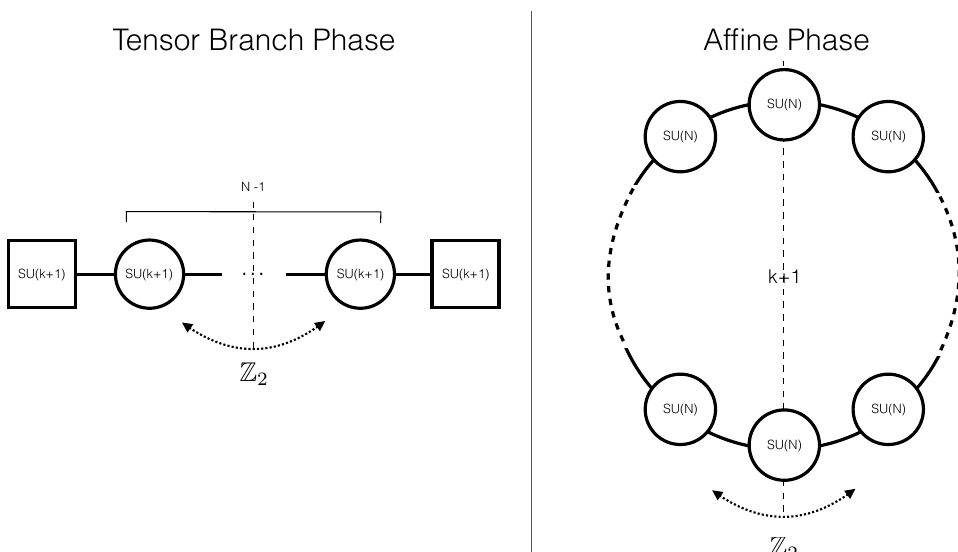
Figure 1 . The two quiver phases of A-type class S theories compacti(cid:12)ed on a T 2 . In addition, (cid:0) the e(cid:11)ect of quotienting by the global symmetries associated to the outer automorphisms is shown. On the left the reduction on the tensor branch yields ( N (cid:0) 1) SU( k + 1) gauge nodes and two SU( k + 1) (cid:13)avor symmetry factors. On the right the a(cid:14)ne quiver with ( k + 1) SU( N ) gauge nodes. The segments represent standard N = 2 hypermultiplets in the bifundamental